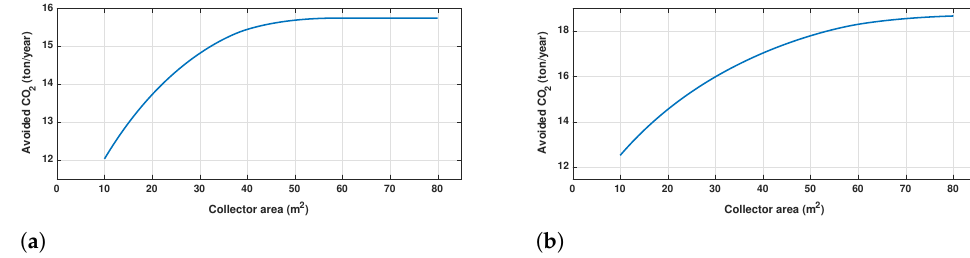
Figure 10. Annual avoided CO 2 versus solar collector area for two different cooling loads: ( a ) 10 kW, ( b ) 20 kW. Table 7. The comparison between base case and environmental friendly case.